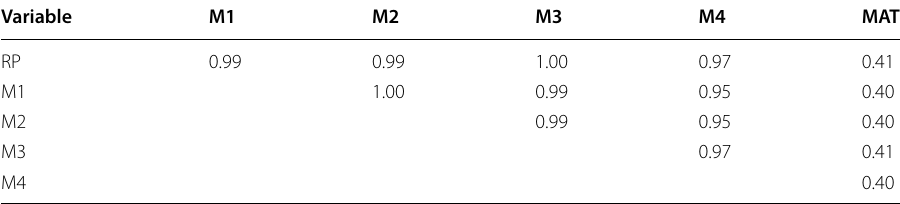
RP, HRL index replicating the scaling model from Martin et al. (2013); M1, HRL index using scaling model 1; M2, HRL index using scaling model 2; M3, HRL index using scaling model 3; M4, HRL index using scaling model 4; MAT, mathematics achievement of fourth